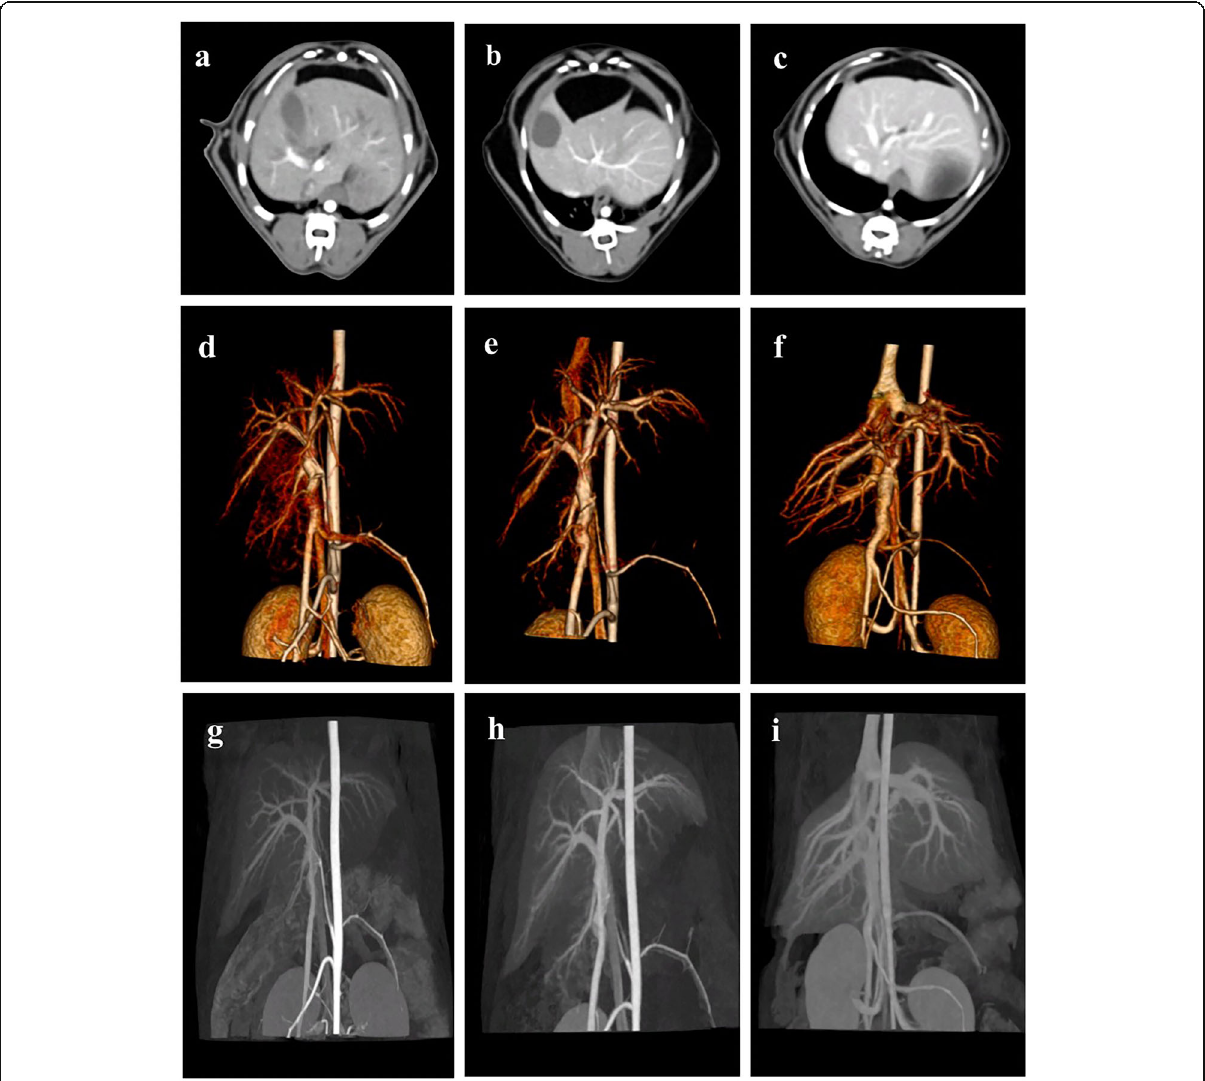
Fig. 3 Triple-phase hepatic CT images of the portal phase at different TDs (5 s, 7 s and 9 s). Portal venous phase images at 5 s TD: hepatic transverse CT image ( a ), hepatic vessel VR image ( d ) and MIP image ( g ). The portal venous phase images at 7 s TD: hepatic transverse CT image ( b ), hepatic vessels VR image ( e ) and MIP image ( h ). The portal venous phase images at 9 s TD: hepatic transverse CT image ( c ), hepatic vessels VR image ( f ) and MIP image ( i ). All images have the same orientation; R is on the left of the